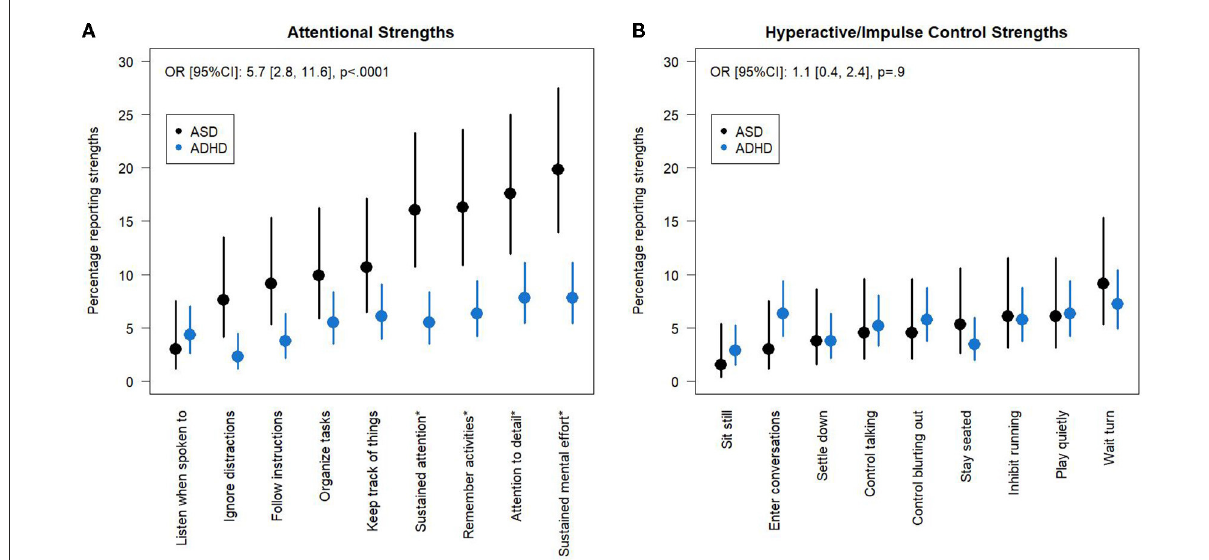
FIGURE2 Attentional and hyperactive/impulse control strengths in ADHD and ASD groups. Percentage (95% CI) of ASD and ADHD groups who report (A) attentional strengths and (B) hyperactive/impulse control strengths. Items with a score of 2 or 3 are classified as strengths. Odds Ratios were estimated for the group effect in models with no group x item interaction term. Items that are significantly different between the two groups using a post-hoc Tukey Adjustment in a model with a group x interaction term are indicated by a * in the axis label. CI, Confidence